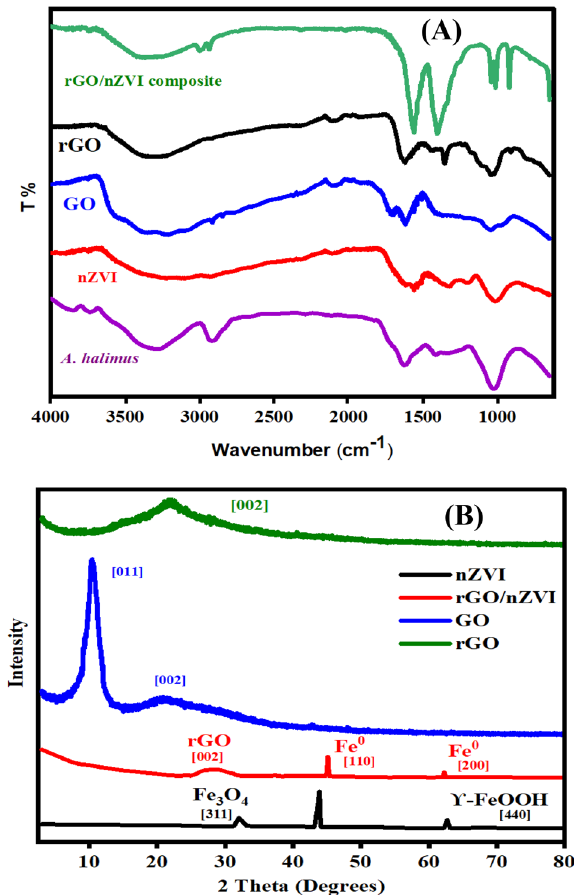
Figure 3. FTIR spectrum of A. halimus , nZVI, rGO, GO, rGO/nZVI composite ( A ). XRD pattern of rGO, GO, nZVI and rGO/nZVI composite ( B